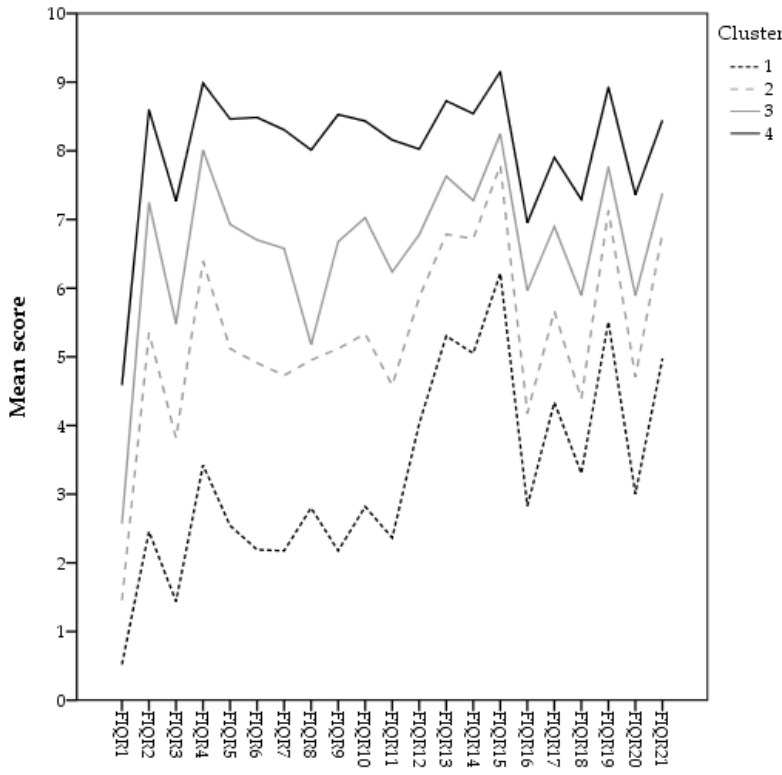
Figure 1. Hierarchical clusters distribution (calculator-derived) .